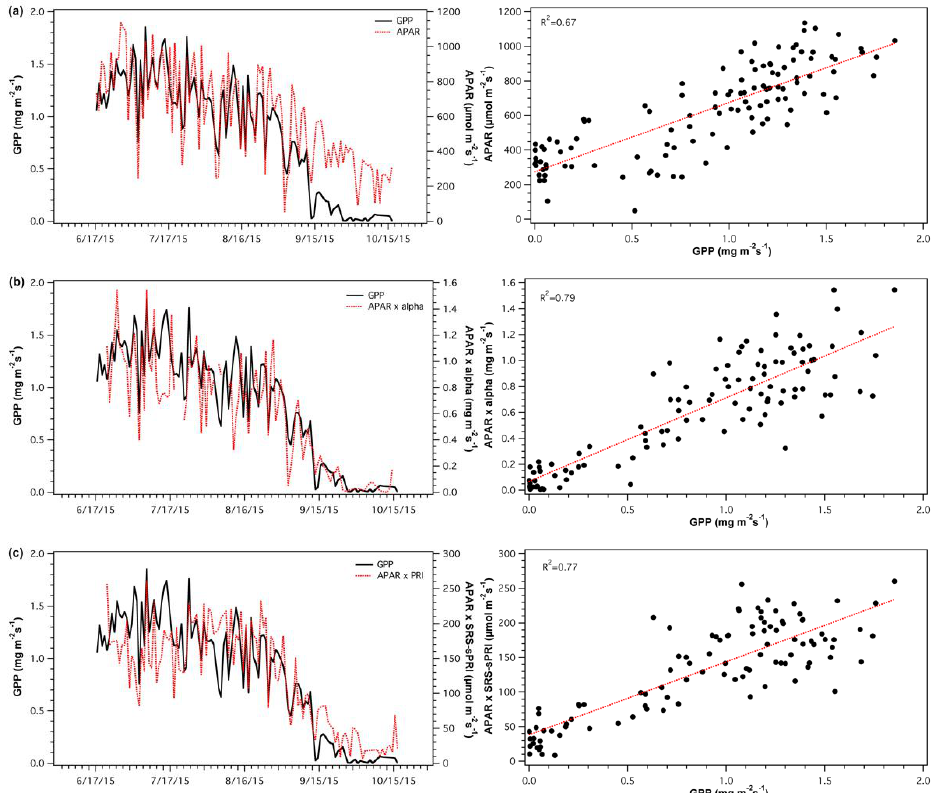
Figure 11. Time series (top panels) and regressions (bottom panels) of ( a ) absorbed photosynthetically active radiation (APAR) and gross primary productivity (GPP), ( b ) light use efficiency (LUE) model driven by apparent quantum yield ( α ) and GPP, and ( c ) light use efficiency (LUE) model driven by scaled photochemical reflectance index from SRS sensors (sPRI) and GPP.